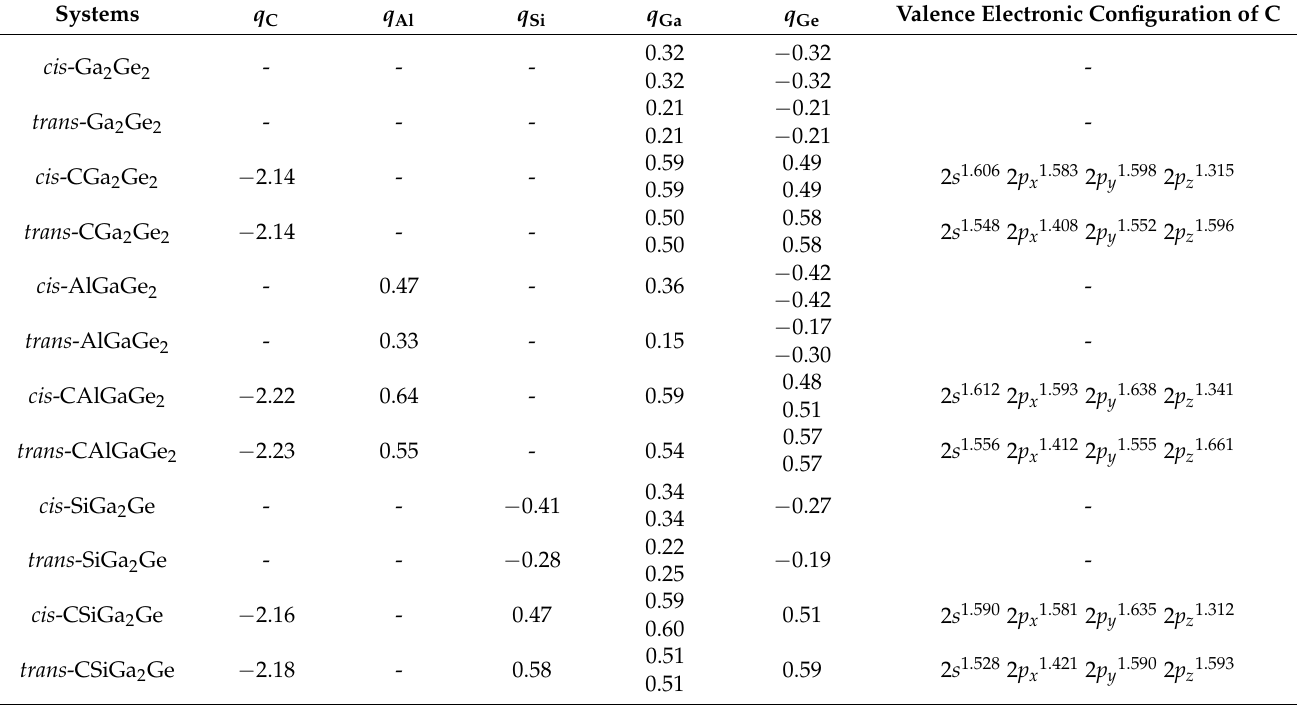
Table 1. The natural charges ( q , | e |) on the atoms in the rings and the ptC systems and the valence electronic configuration of C atom in the ptC